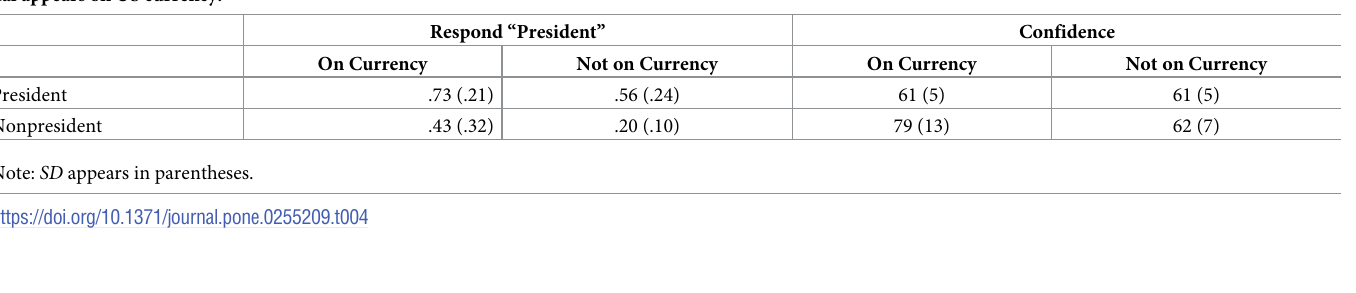
Table 4. Mean hit and false alarm rates and subjects’ mean confidence when responding “president” to a face in Experiment 1 as a function of whether the individ- ual appears on US